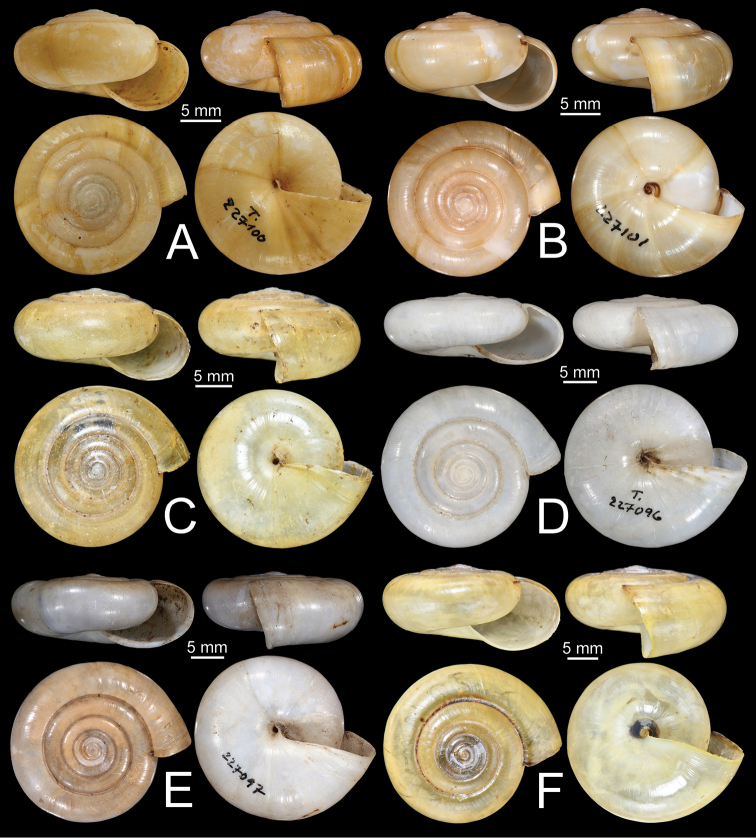
Shells of group I: Sarika
resplendens group. A–CSarika
limbataA syntype SMF 227100, B syntype SMF 227101, and C specimen CUMZ 7652 D–FS.
heptagyraD syntype SMF 227096 E syntype SMF 227097, and F specimen CUMZ 7231.